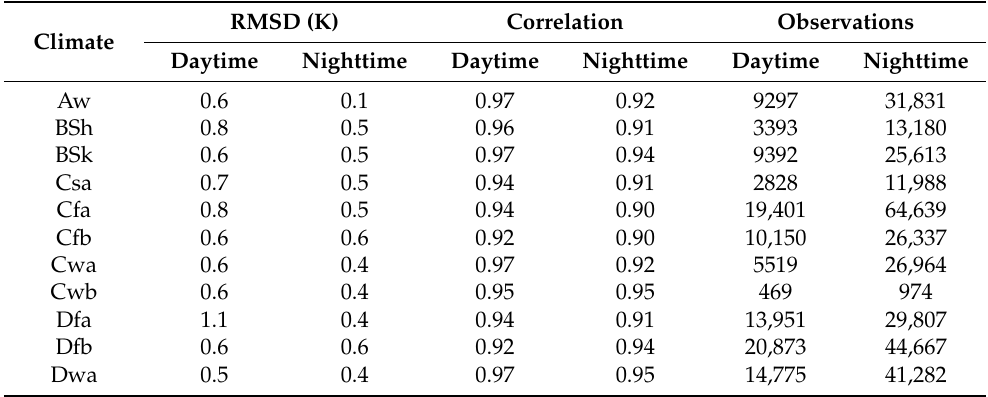
Table A1. The Root-Mean-Square-Deviation (RMSD) and the correlation coefficient between the 2000–2018 LST_cci and MOD11A1 (v.6.0) SUHII for each Köppen–Geiger climate